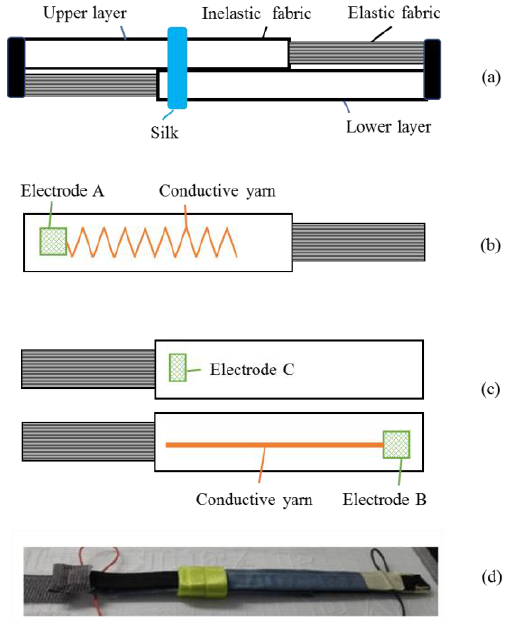
Figure 1. ( a ) The structure of the sensor; ( b ) the upper layer; ( c ) the lower layer; and ( d ) a picture of the sensor.